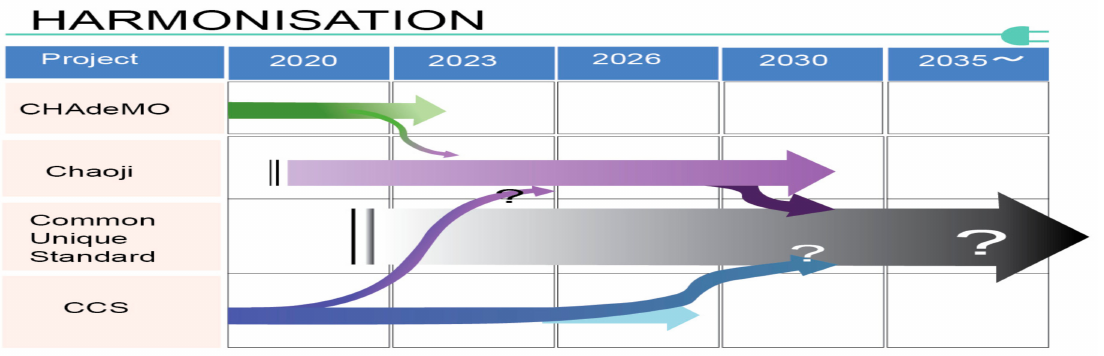
Figure 30. Polymodal to monomodal EV rapid charge connector model. Adapted from source